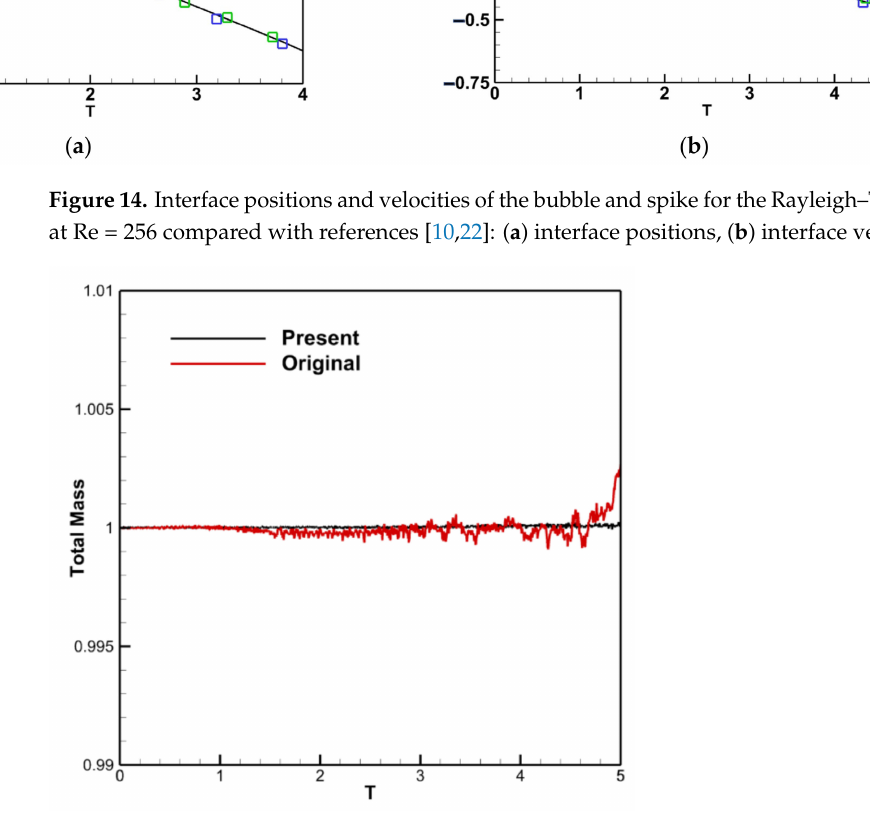
Figure 15. Variation in the mass for the lighter fluid at Re =